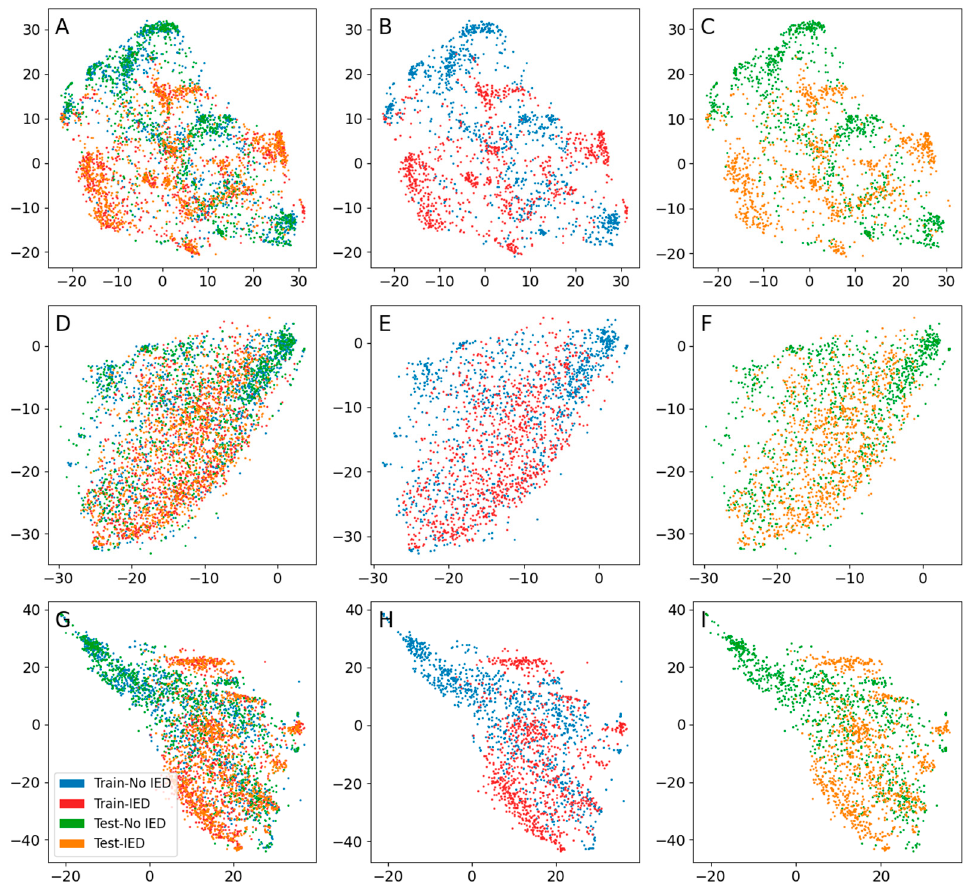
Figure 5. Low-dimensional representations of the IED dataset. Each dot represents 1 s of data. First row ( A – C ): CNN. Second row ( D – F ): STFT. Third row ( G – I ): CWT. First column ( A , D , G ): all data. Second column ( B , E , H ): training data. Third column ( C , F , I ): test data. Table 3. Quantitative measures for the IED dataset. Significantly higher values in a column are in bold (chi-square test). κ indicates the kappa value for SVM; L indicates a linear kernel; R indicates a radial basis function kernel; C indicates the number of clusters by k-means.